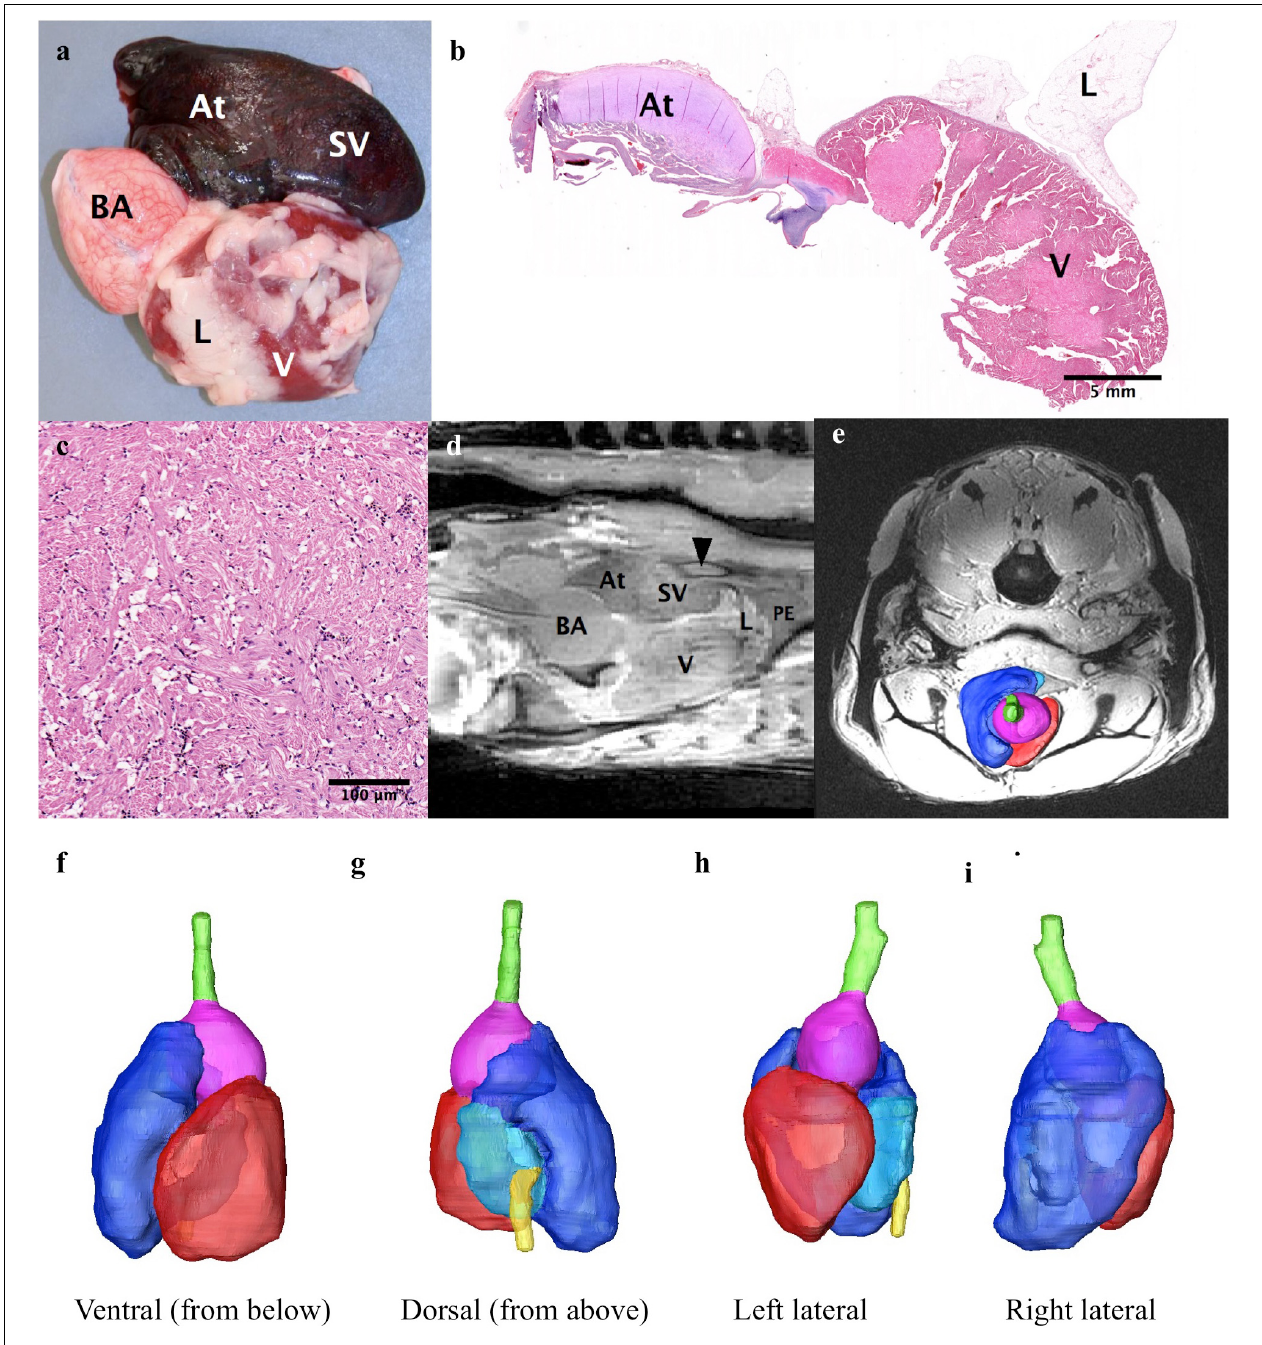
FIGURE 6 | The heart. (a,b,d) The heart consists of the sinus venosus (SV), the atrium (At), the ventricle (V) and the bulbus arteriosis (BA). Some of the substantial lipid rich connective tissue that surrounds the heart can be seen (L). (c) Photomicrograph of the ventricular myocardium. (d) Sagittal MRI of the heart showing the ductus of Cuvier (arrowhead) connecting to the sinus venosus. A small amount of pericardial effusion (PE) can be seen at the apex of the heart. (e–i) e- 3D reconstruction of heart superimposed on axial MRI for orientation of heart. (f) Ventral (seen from below), (g) Dorsal (from above), (h) Left lateral, (i) Right Lateral. Hepatic vein: yellow, sinus venosus: light blue), atrium: dark blue, ventricle: red, bulbus arteriosus: purple.